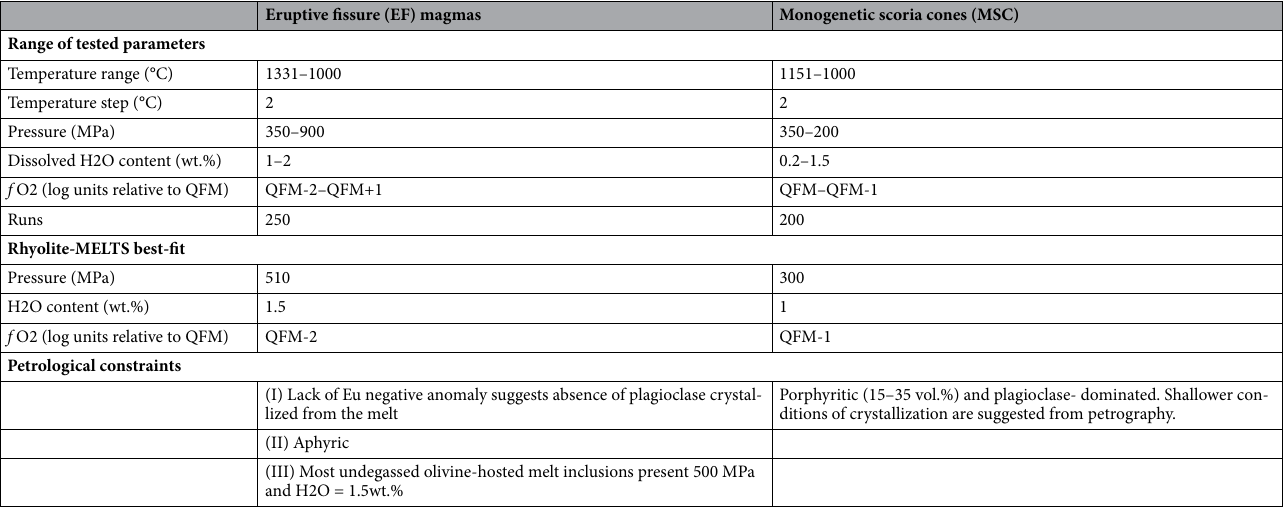
Table 1. Range of tested parameters and best-fit magma storage conditions for EF and MSC products constrained via Rhyolite-MELTS